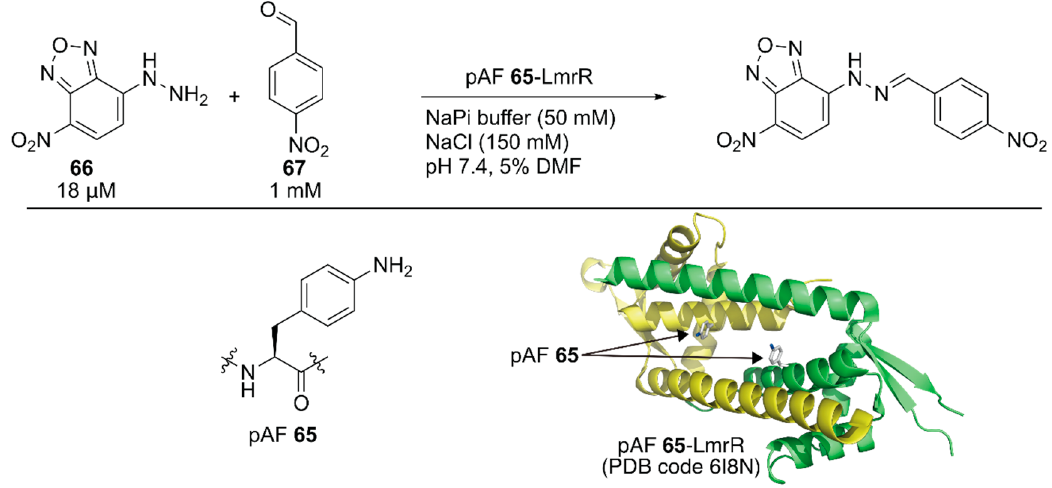
Figure 13. Hydrazine formation catalyzed by an artificial enzyme containing an unnatural amino acid at the active site. Adapted from [92].